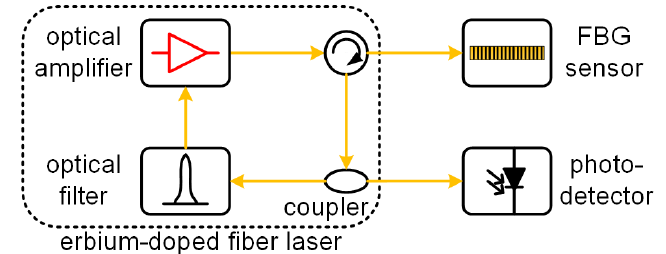
Figure 6. The FBG demodulation system using an erbium-doped fiber laser.